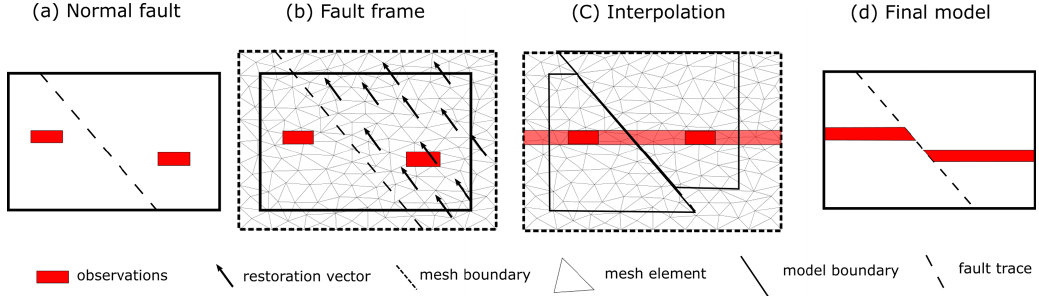
Figure 3. Schematic diagram showing proposed workflow to integrate fault kinematics to implicit modelling. (a) Observations of reverse fault. (b) Fault frame with restoration vectors showing. (c) Observations and model domain are restored for interpolation; the mesh where interpolation occurs is not deformed and is built in the restored space. (d) Final model is evaluated by applying fault restoration kinematics and evaluating scalar field from mesh in (c)